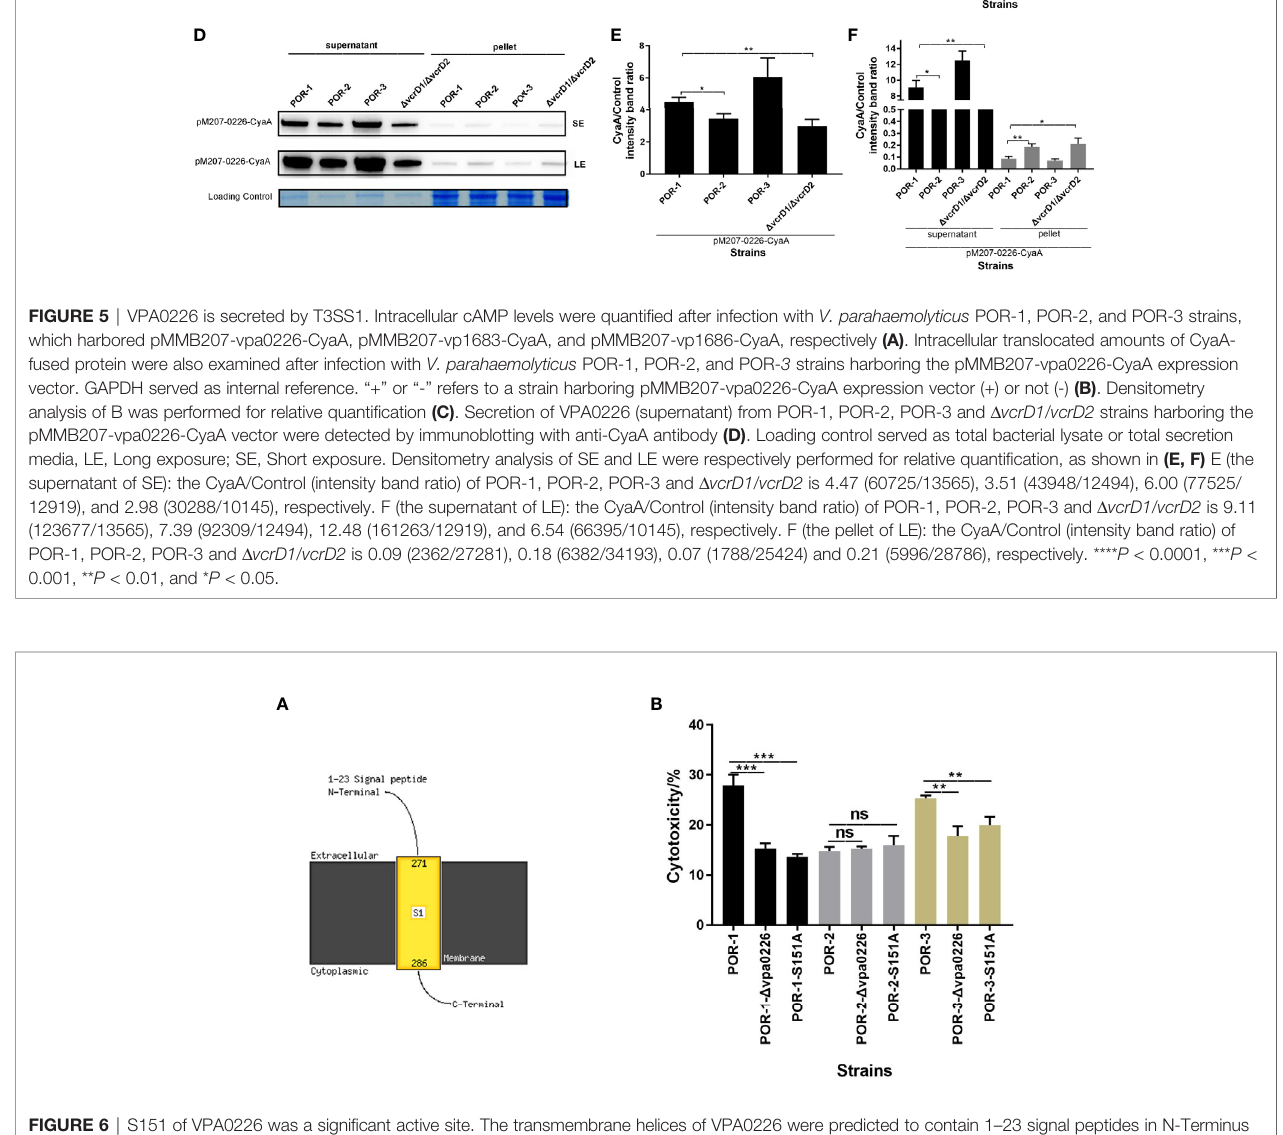
FIGURE 6 | S151 of VPA0226 was a signi fi cant active site. The transmembrane helices of VPA0226 were predicted to contain 1 – 23 signal peptides in N-Terminus using Phyre2 (A) . The cytotoxicity of V. parahaemolyticus vpa0226 -related mutant strains were examined using infected HeLa cells (B) . *** P < 0.001, ** P < 0.01. ns, indicates no signi fi cant